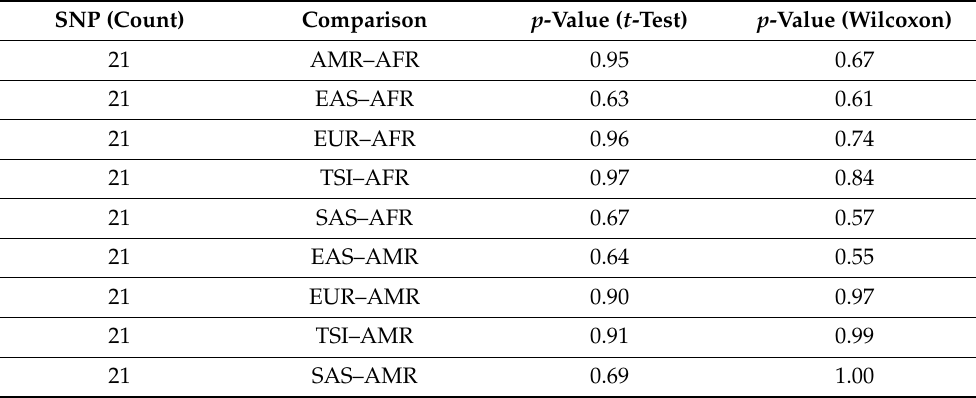
Table 2. Comparison of mean load of “antisocial susceptibility variants” across populations. SNP